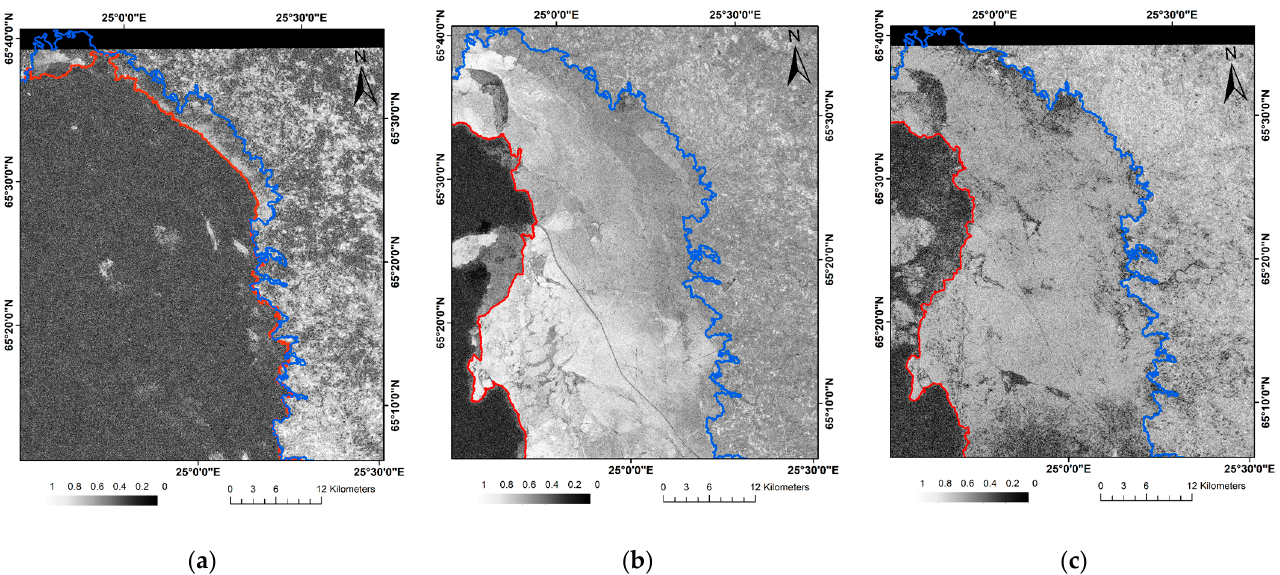
Figure 5. The extracted results by the reference method: ( a ) The seaward edge lines of landfast ice extracted by image pair 2; ( b ) The seaward edge lines of landfast ice extracted by image pair 3; ( c ) The seaward edge lines of landfast ice extracted by image pair 4. The blue line represents the land–water boundary extracted by modified approach and the red lines represent seaward edge lines of landfast ice. Table 2. Statistical parameters of segments.